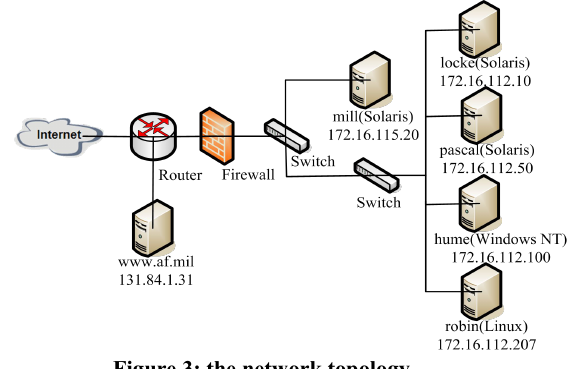
Figure 3: the network topology